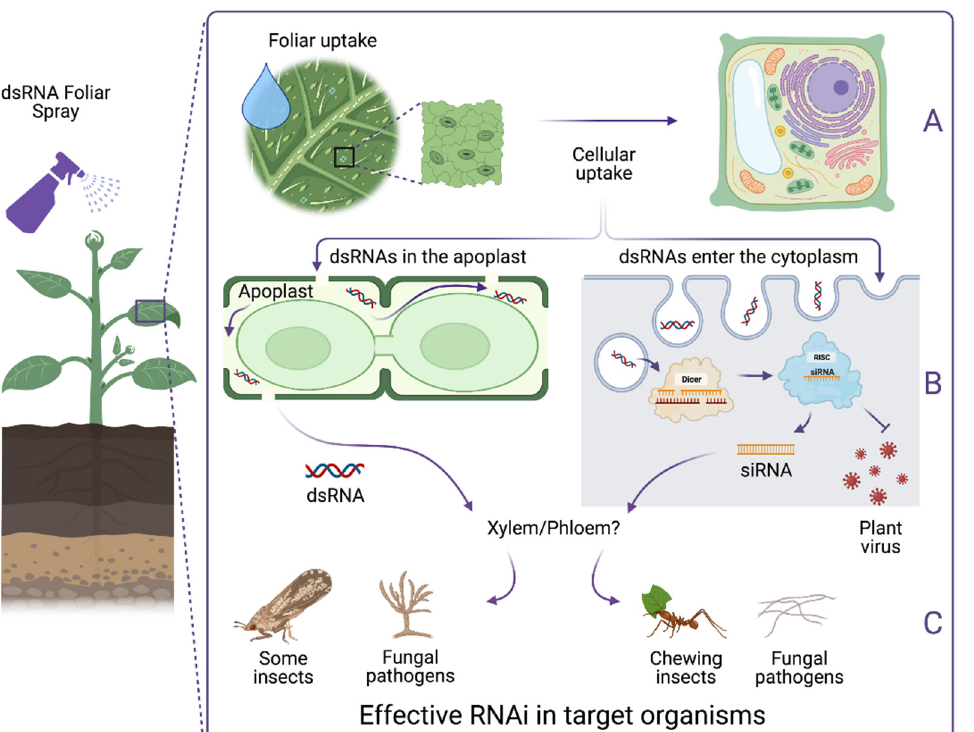
Figure 1. Functional crop protection via a foliar dsRNA spray to induce RNAi. ( A ) . Plant uptake of dsRNA can be divided into two stages: foliar uptake where sprayed dsRNA molecules from the leaf surfaces enter the interior of the leaf tissue, and cellular uptake where dsRNA molecules get taken up into plant cells. Following foliar uptake, sprayed dsRNAs may diffuse through the leaf interior and cellular uptake may occur. ( B ) . Once dsRNA penetrates the cell wall pores and cell membrane to enter the cytoplasm, the plant RNAi machinery can process dsRNAs into siRNAs. Produced siRNAs can lead to degradation of viral transcripts in local cells and also be transported to adjacent cells. siRNAs are likely to participate in long distance signaling through vascular bundles to other parts of the plant. It is uncertain how non-processed dsRNA in the apoplastic pathway are translocated systemically. ( C ). dsRNA/siRNAs from the plant surfaces or in the plant system can be taken up by different targets and trigger an RNAi response depending on their sensitivity to dsRNA or siRNA. Figure created with BioRender.com.